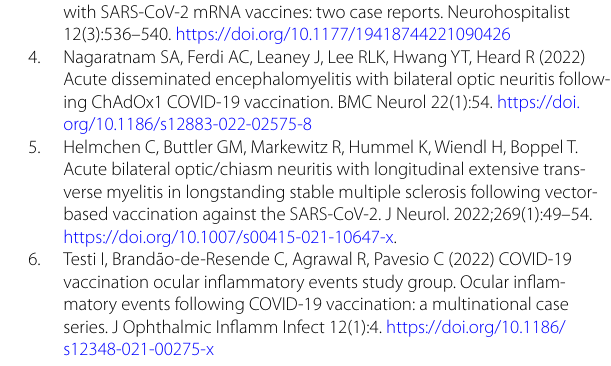
AION Anterior, ischemic optic neuropath, AV Acyclovir, AZV AstraZeneca vaccine, BCVA Best corrected visual acuity, hm Hand movement, LVOD Latency between vaccination and ophthalmologic disease, nm Not mentioned,: previous ophthalmologic disease, SAB Subarachnoid bleeding, ST Steroids